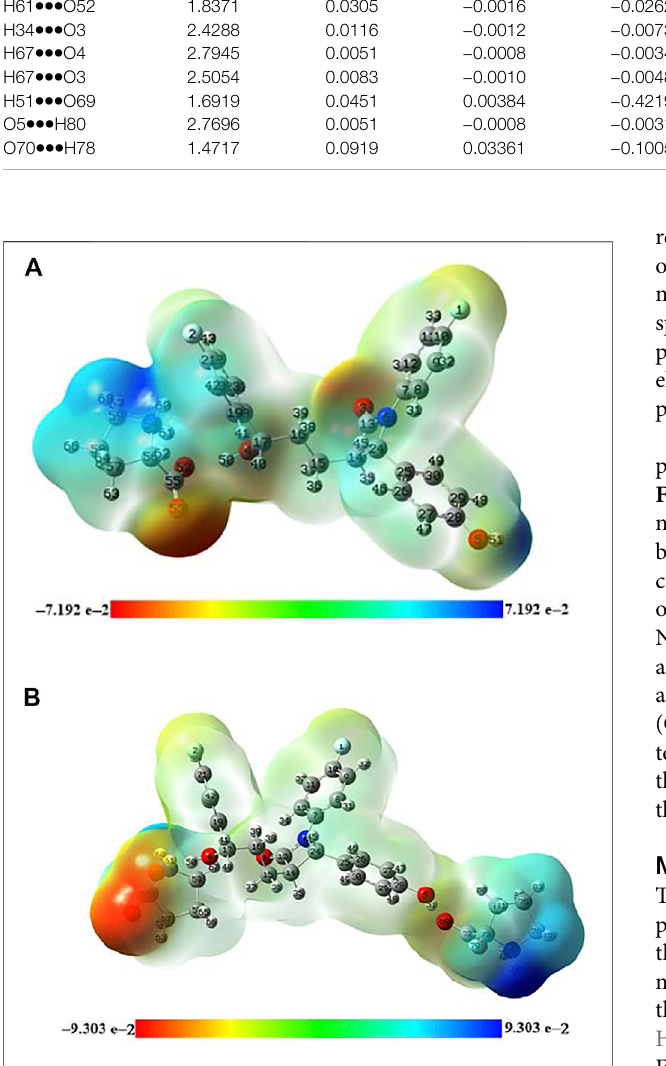
FIGURE6|(A) Molecularelectrostaticpotentialsurface(MEPS)ofEZT+ L-proline formed by mapping total density over electrostatic potential in the gas phase. (B) Molecular electrostatic potential surface (MEP) of EZT + 2L- prolineformedbymappingtotaldensityoverelectrostaticpotentialinthe gas